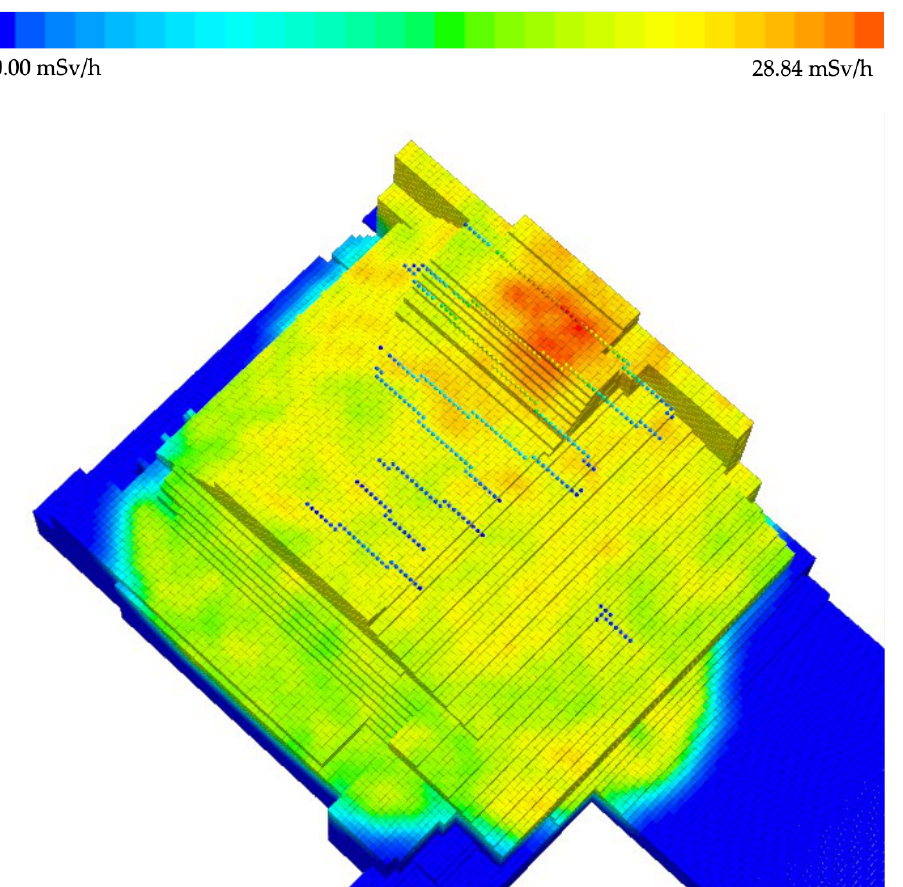
Figure 4. Result of 7000 iterations of the evolutional algorithm, yielding a color-scaled map of the radiation levels on the roof of the shelter object.